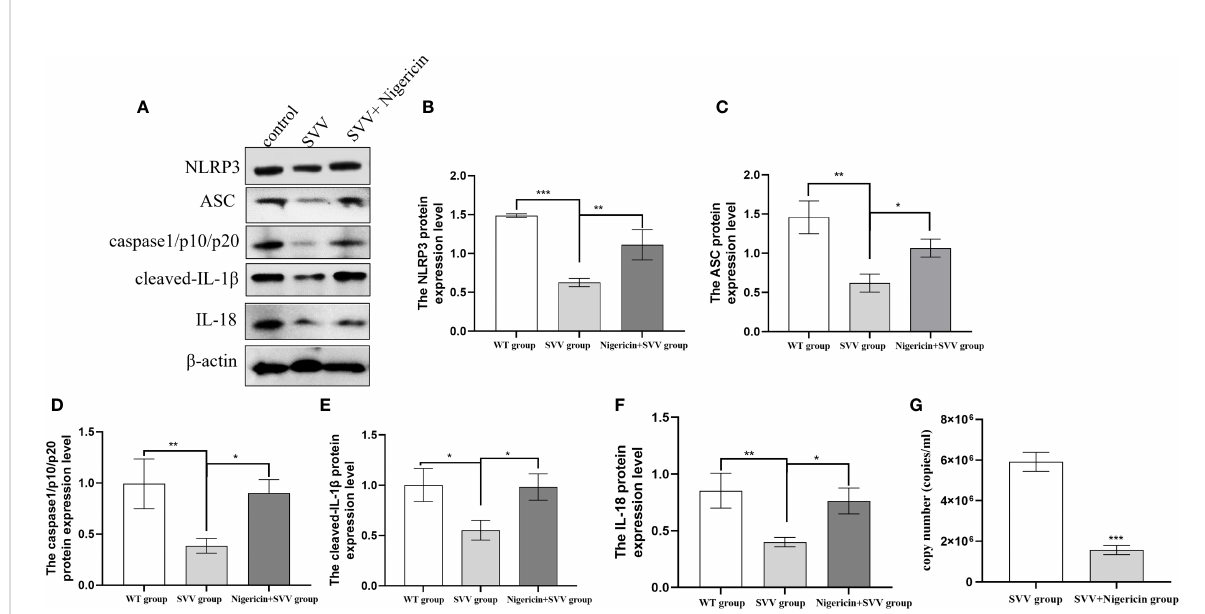
FIGURE 3 NLRP3 in fl ammasome activator (Nigeration) relieved SVV inhibited NLRP3 in fl ammasome activation and suppress SVV proliferation in PK-15 cells (A) The western blot assay for NLRP3, ASC, caspase1/p10/p20, cleaved-IL-1 b and IL-18. (B – F) The relative protein expression level of NLRP3, ASC, caspase1/p10/p20, cleaved-IL-1 b and IL-18. (G) The qRT-PCR assay for SVV copy number. One-way analysis of variance (ANOVA) were used to investigate the signi fi cance of differences between the SVV groups and the SVV+BX795 group or between the control group and SVV group *; P < 0.05, **; P < 0.01, ***; P <